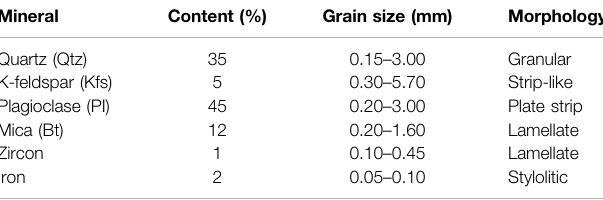
TABLE 1 | Mineral content and the grain size of the Shuangjiangkou